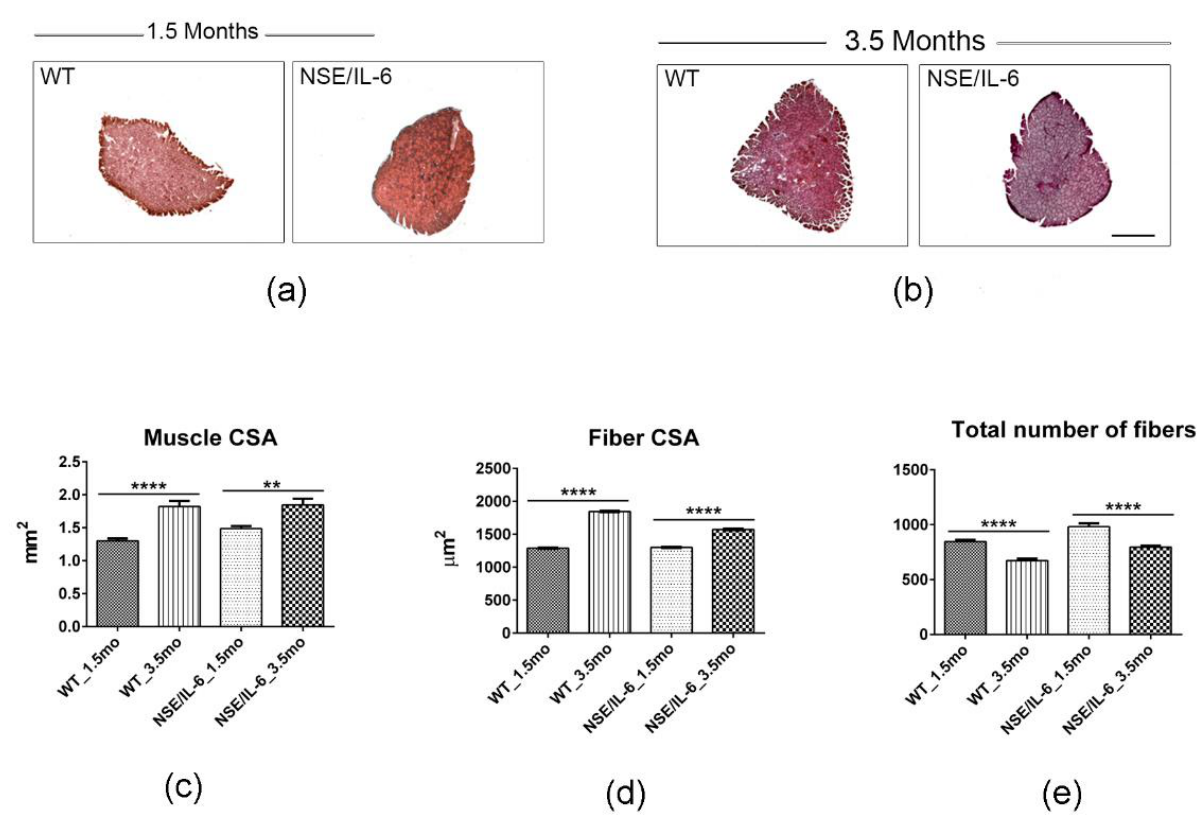
Figure 2. IL-6 overexpression significantly impairs muscle growth during the postnatal life. ( a , b ) Hematoxylin and eosin staining of transverse section of soleus muscles from indicated genotypes at 1.5 and 3.5. Scale bar 500 µ m. ( c – e ) The graphs show quantification of total cross-sectional area (muscle CSA) ( c ), fibers-cross sectional area (Fiber CSA) ( d ) and total number of fibers ( e ) in soleus muscles of wild type (WT) and NSE/IL-6 (IL-6) mice at 1.5 and 3.5 months of age. Data are represented as average ± SEM. n = 10 mice; ** p < 0.01, **** p < 0.0001. Statistical significance assessed by two-way ANOVA.